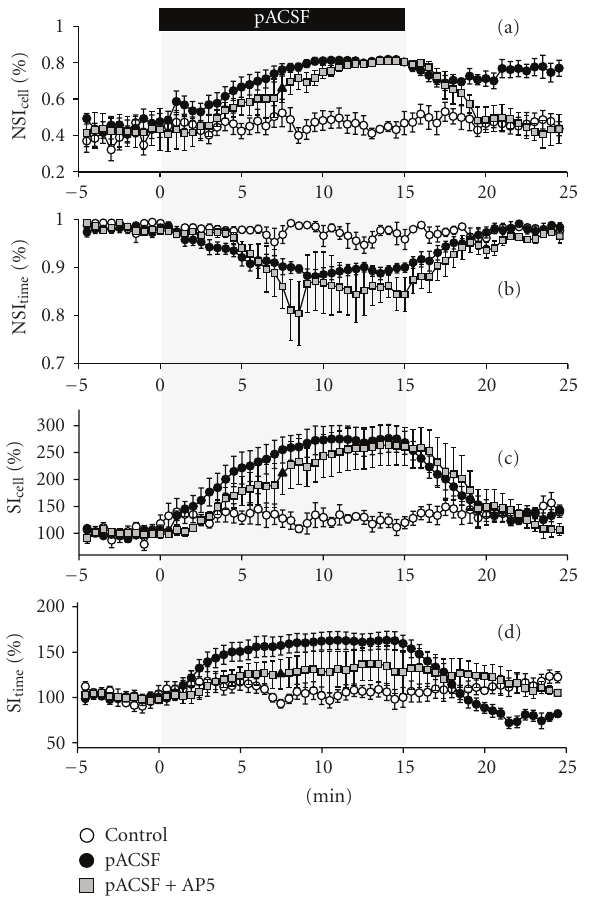
Figure 3: pACSF induces an NMDA-dependent persistent increase in NSI cell , but not NSI time . The same data as Figures 1(c) and 1(d) and data of perfusion with pACSF in the presence of 50 μ M AP5 were analyzed with the NSI cell (a), NSI time (b), %SI cell (c), and %SI time (d) indices (Control, N = 5; pACSF, N = 8; pACSF+AP5, N = 4). (a) and (b) pACSF-induced increase in NSI cell persisted after replacement with normal ACSF, an e ff ect that was prevented by AP5, whereas pACSF-induced increase in NSI time was recovered to the pre-pACSF baseline level after pACSF washout. (c) and (d) show that neither %SI cell nor %SI time detected pACSF-induced plastic changes. Data are means ± SEMs.